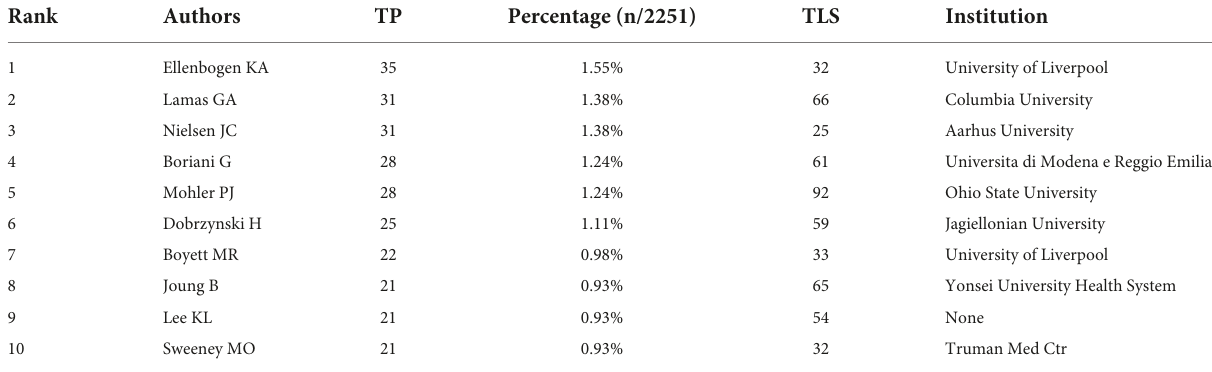
TABLE 3 The top 10 productive authors of sick sinus